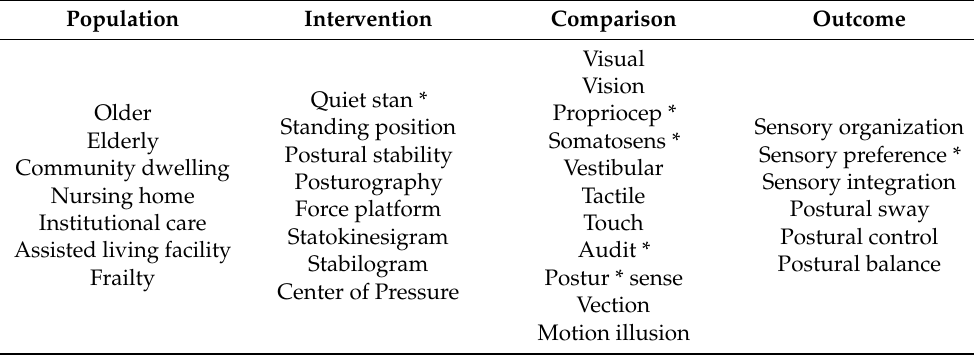
Table 1. Keywords that will be used for each of the PICO domains. An asterisk (*) represents any group of characters and will be used to search for multiple variants of a word.